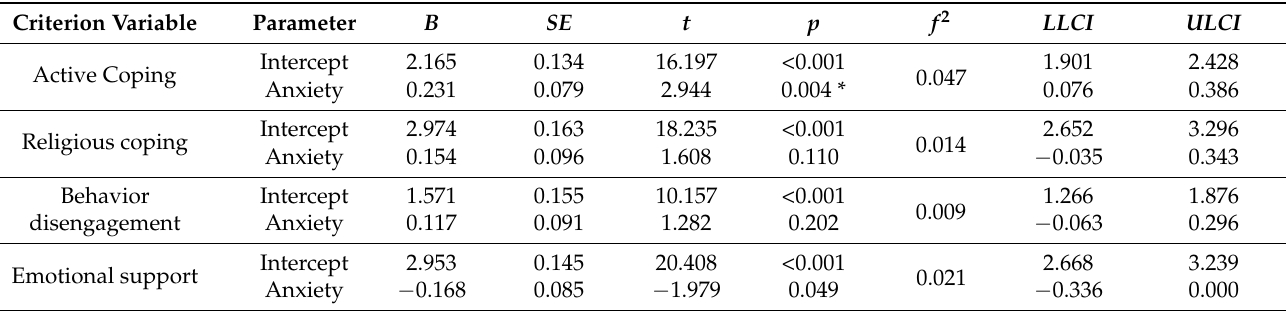
Table 3. Parameter estimates.